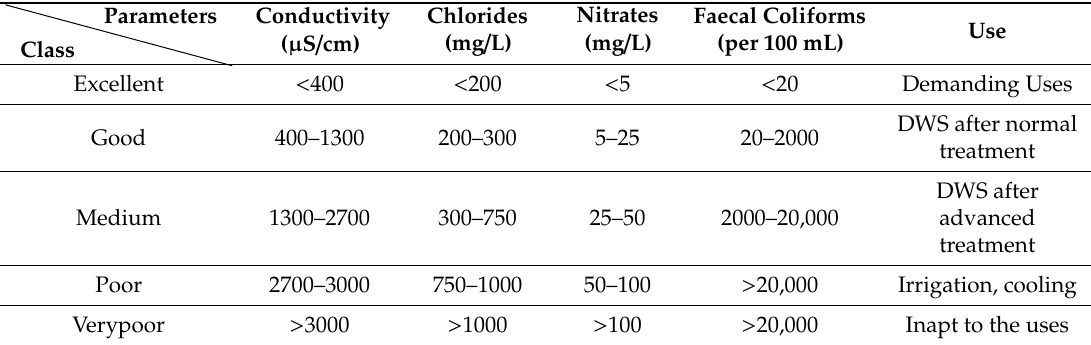
Table 3. Simplified grid for assessing the overall quality of groundwater [37].